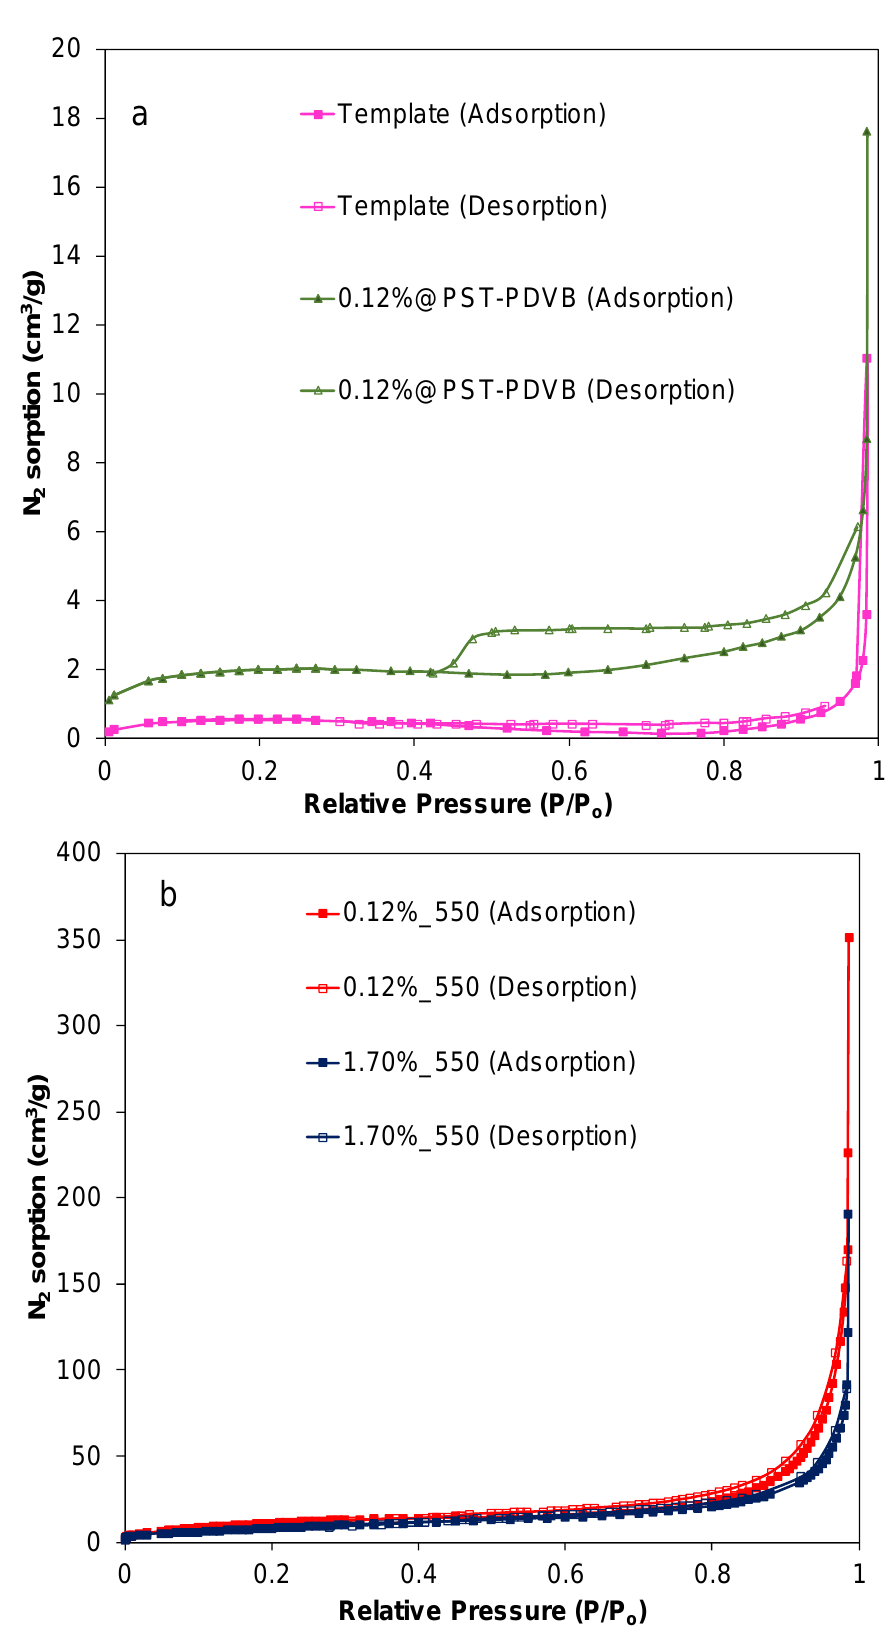
Figure 6. ( a ) N 2 adsorption–desorption isotherm curves of the template and of the Ti 0.988 Tb 0.012 [(OH) 4 − u Cl v ]@PST–PDVB composite. ( b ) N 2 adsorption–desorption isotherm curves of 0.12%_550 HSs and 1.70%_550. Figure 7 shows the XRD diffraction patterns of the template (a) after the simulta- neous implantation of both TiCl 4 and TbCl 3 (0.12 at.% Tb) to the carbonyl groups of the template, followed by the addition of HCl aq , i.e., when the hydrolysis and polycondensa- tion reactions are taking place (b), and after calcination at 550 °C for 30 min (c). The virgin t emplate exhibited a broad diffraction band at 2θ of the range 15.00 – 30.00 ° suggesting the amorphous structure of the polymeric scaffold (Figure 7a). However, in the case of the intermediate product formed after implantation and the partial hydrolysis and poly- condensation reactions (Figure 7b), the XRD pattern shows a type of semi-crystalline structure in which the intensity of the characteristic reflection band at 2θ = 15.00 – 30.00 ° has diminished without altering its position. The reason for the decrease in intensity is likely due to the accommodation of TiCl 4 and TbCl 3 molecules in the PST – PDVB matrix forming complexes with the template. In addition, new peaks at 18.18, 18.74 and 25.26° (indicated with arrows) could confirm the implantation of both chlorides in the polysty- rene matrix (Figure 7b). In fact, in a previous work, Rahmatpour et al. [17] found a peak at 2θ = 18.06 ° that assigned to the implantation of TiCl 4 onto the PST – PDVB which is in good agreement with that found in this study (18.18°). After calcination at 550 °C for 30 min pure anatase phase was completely crystallized for all compositions (Figure 7c is shown as a way of example). Neither brookite nor rutile phases were noted for any composition calcined at that temperature. In addition, neither metal clusters of Tb nor impurity phases such as Tb oxides were detected.